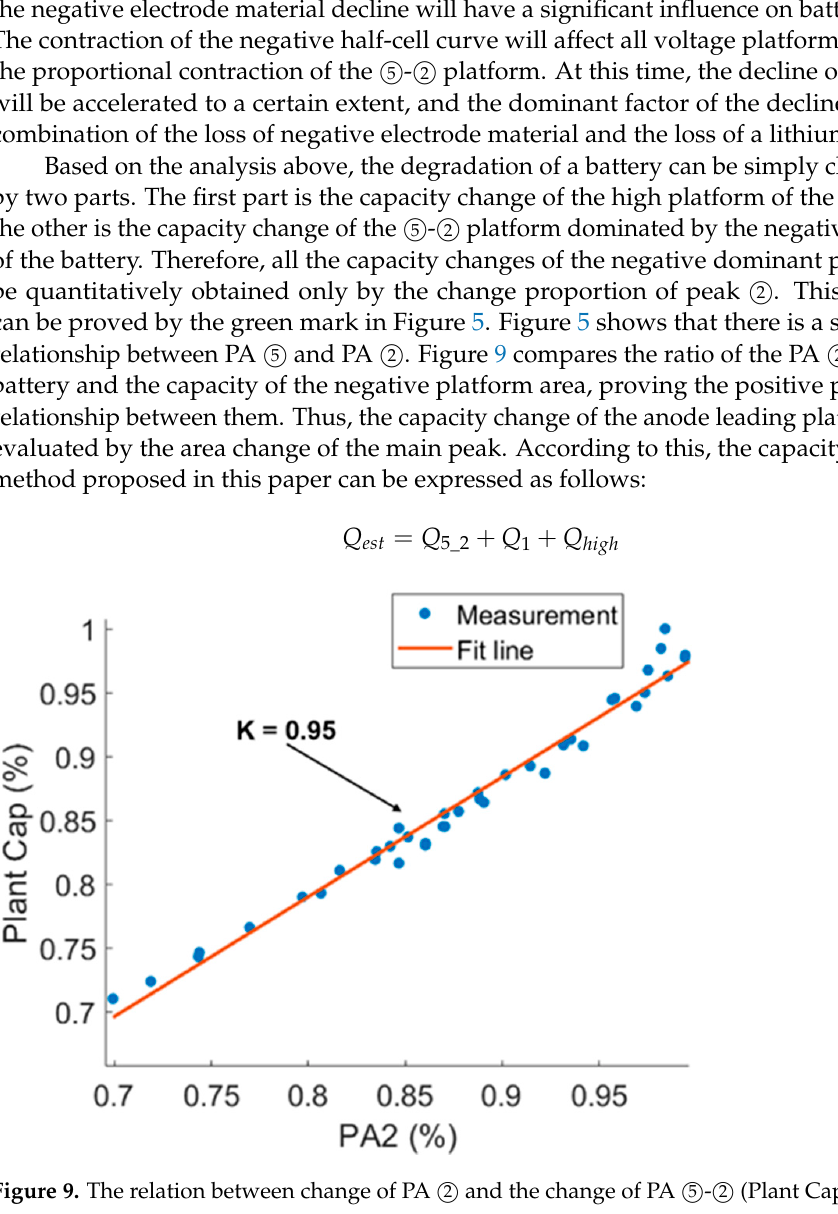
Figure 10. IC curve of retired LiFePO4 battery. 5. Results and Discussion In order to verify the effectiveness of the proposed methods, another set of battery pack data outside the training set is taken as the verification set. In this paper, there are two battery verification sets: the first is the interface capacity set of the model and the other is the aged battery pack capacity data set. The cell capacity data set is shown in Table